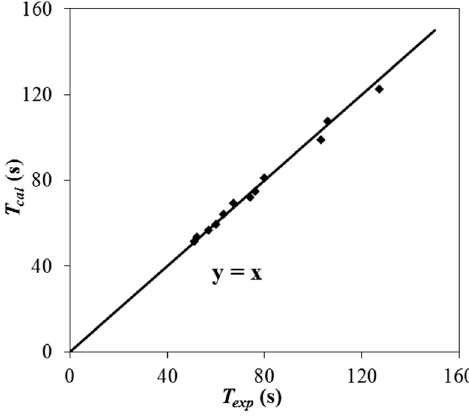
Figure 5. Comparison between T cal and T exp.